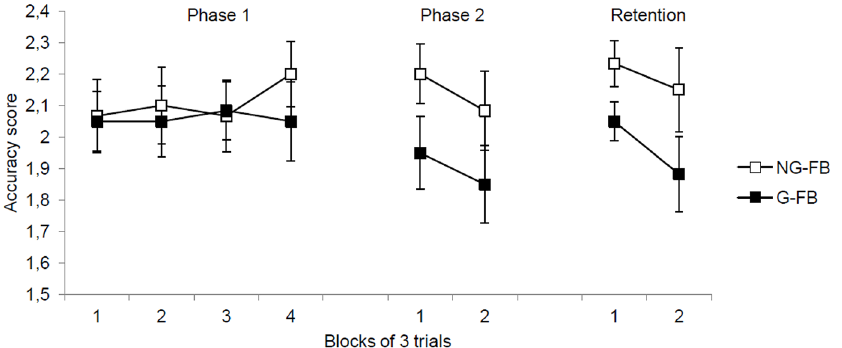
Figure 2. Accuracy scores during phase one, phase two, and retention for the G-FB and NG-FB groups. Error bars indicate standard